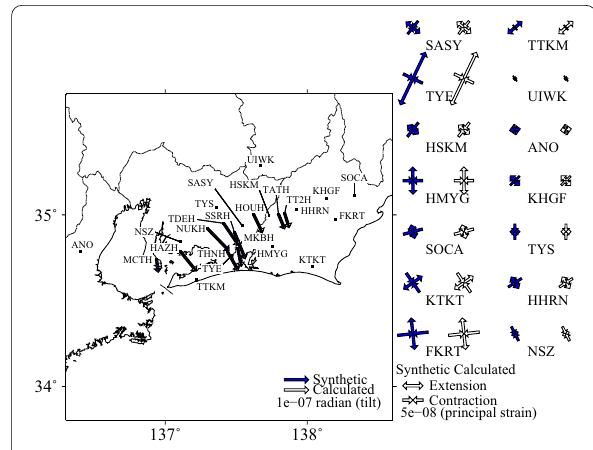
Fig. 4 Horizontal principal strain (arrows in the right panel) and tilt vectors (arrows pointed toward uplift) calculated from the given slip (Synthetic: blue symbols) and the retrieved slip (Calculated: white) shown in Fig. 3c, d. Map region corresponds to Area B in Fig. 1